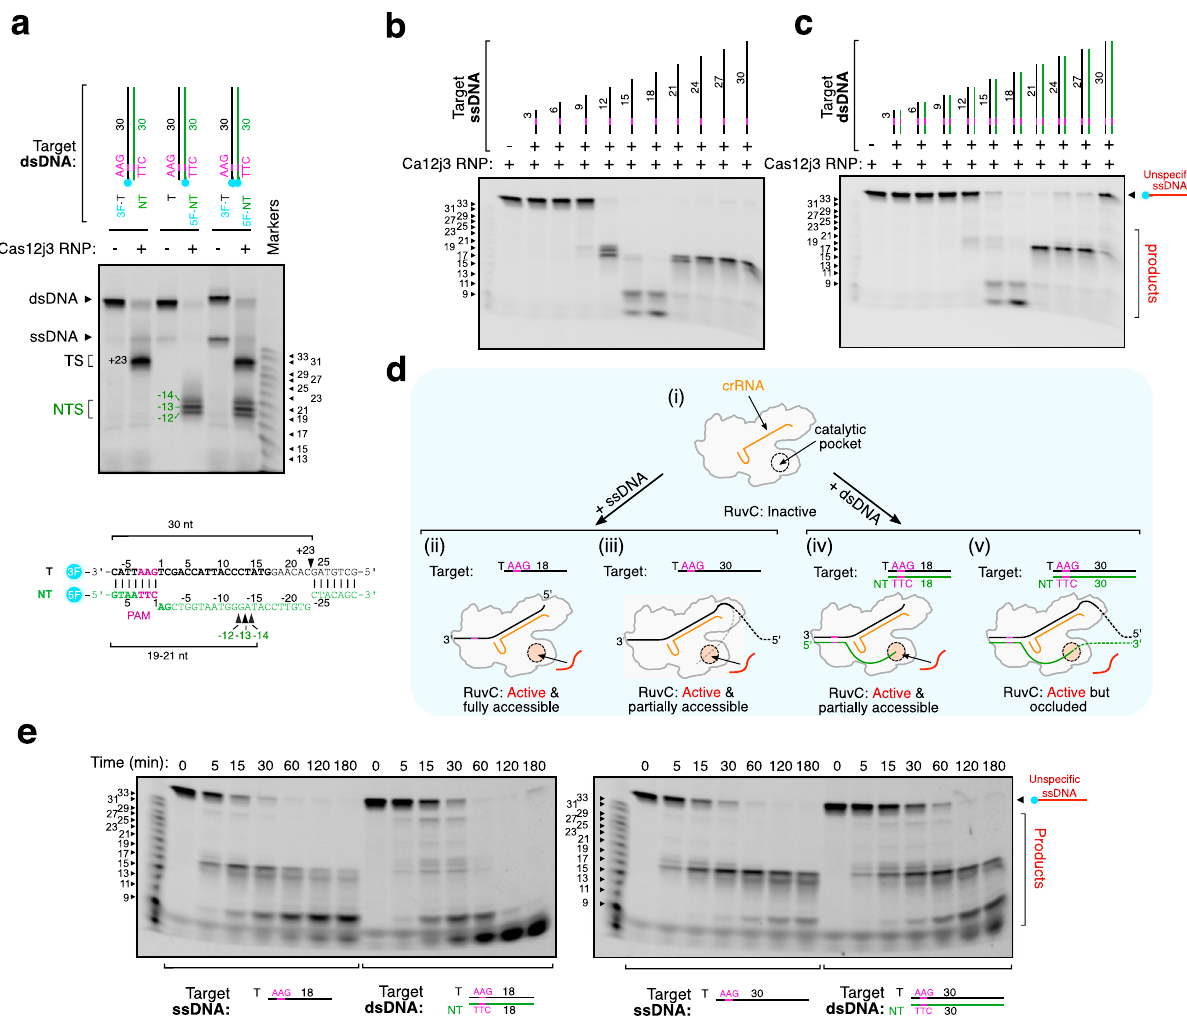
Fig. 1 Cas12j3 target dsDNA cleavage and unspeci fi c ssDNA degradation. a representative dsDNA cleavage pattern generated by Cas12j3 wild type (WT). T-strand (TS) and NT-strand (NTS) products are marked, showing a cut at positions − 13, − 14 and − 15 of the NT-strand, while the T-strand is cleaved at position + 23. The sequence of the double-labelled duplex is shown below, marking the position of the cut (triangles), and the size of the labelled products. b Unspeci fi c ssDNA degradation after activation with a speci fi c target ssDNA of different lengths (Oligonucleotides T-AAG-3 to T-AAG-30 in Supplementary Table II). c Unspeci fi c ssDNA degradation after activation with a speci fi c dsDNA activator of different lengths (Oligonucleotides T-AAG-3/ NT-TTC-3 to T-AAG-30/NT-TTC-30 in Supplementary Table II). d Schematic cartoon of the results shown in b) and c). Activation of the unspeci fi c ssDNA cleavage is observed between 12 – 30 nt. (i) The RuvC domain of Cas12j3 RNP is inhibited. Full activation of the unspeci fi c cleavage is observed when using an ssDNA or dsDNA activator pairing with the crRNA between 12 – 18 nt (ii and iv). The use of longer oligos as ssDNA(iii) or dsDNA (v) results in a reduction of the cleavage ef fi ciency, likely due to a steric occlusion of the catalytic site by the T-strand and NT-strand. e Unspeci fi c ssDNA degradation time course by Cas12j3 activated by 18 and 30 nt, ss- and dsDNA targets. The DNA markers indicate the size of the products in nucleotides. The experiments are shown in a – c and e are representative of three independent experiments with similar